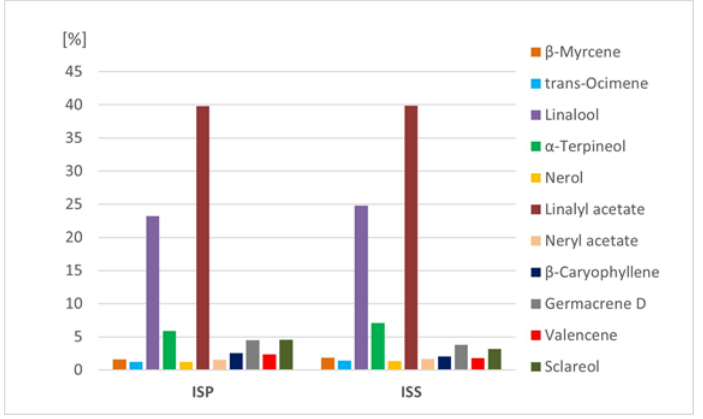
Figure 4. Principal components of the essential oils of primary inflorescences (ISP) and secondary inflorescences (ISS).